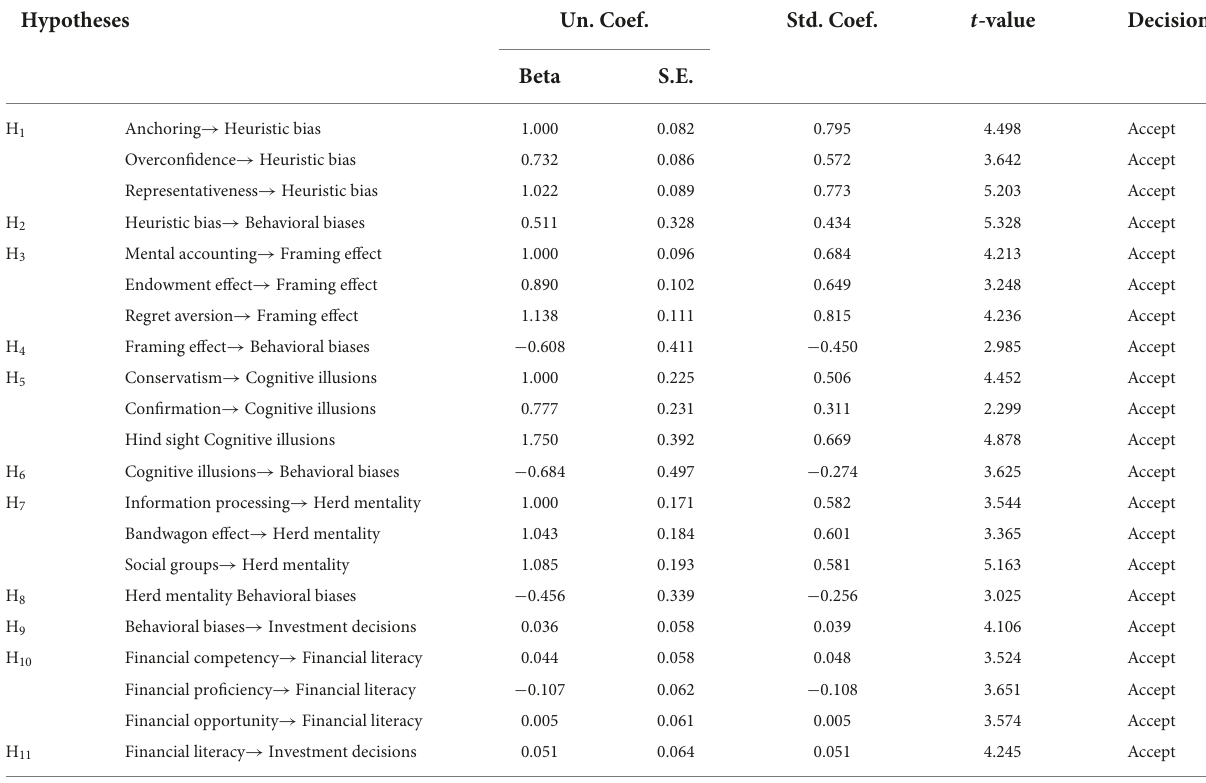
TABLE 5 Testing of